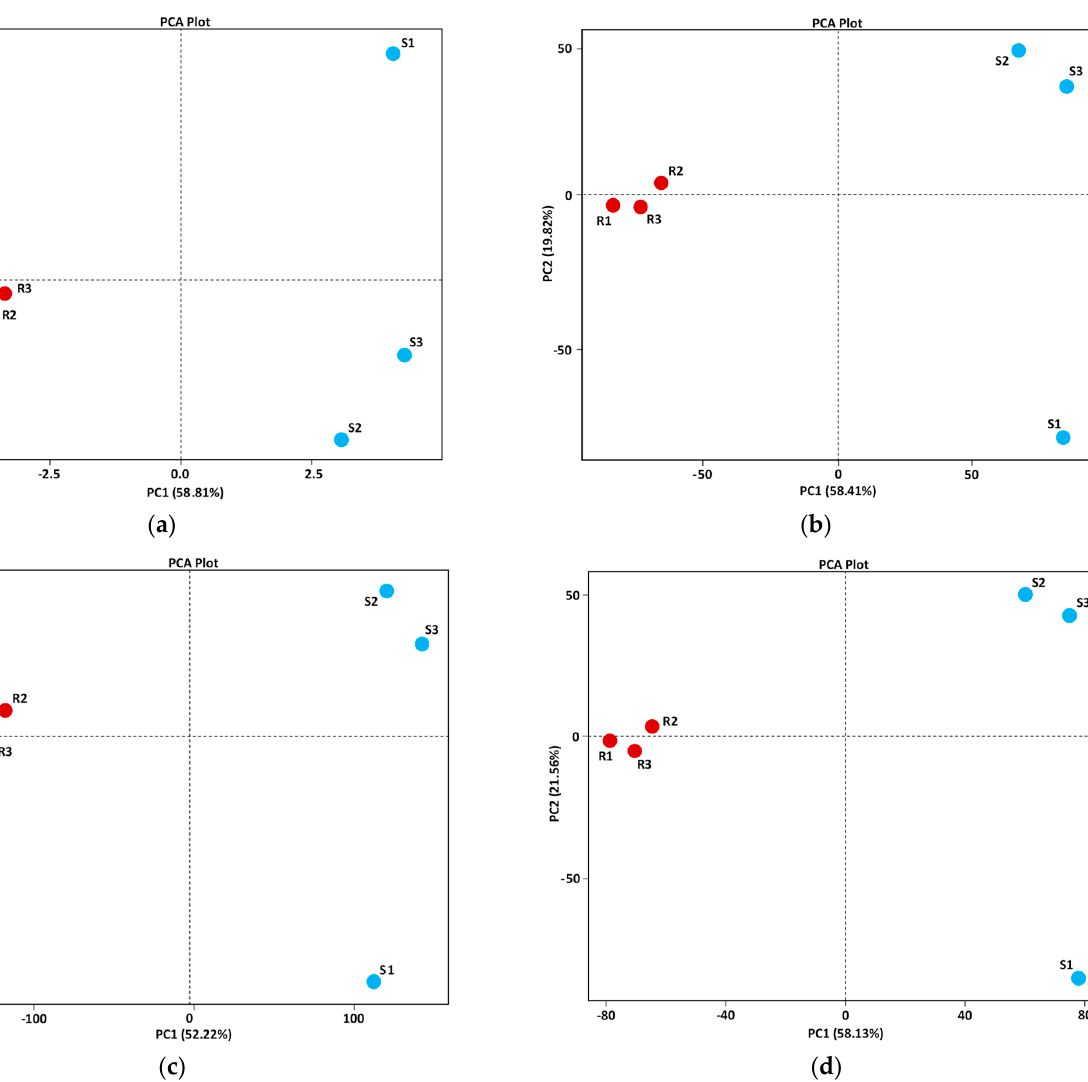
Figure 1. Principle component analysis (PCA) based on KEGG (Kyoto Encyclopedia of Genes and Genomes) database Levels 1 ( a ), 2 ( b ), 3 ( c ), and EC ( d ) referring to prokaryotic and eukaryotic mi ‐